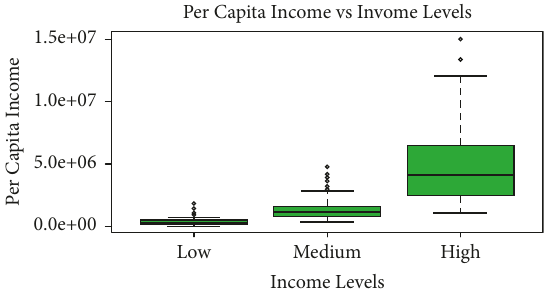
Figure 5: Box-plot of per capita income ( y -axis in TZS) in low, medium, and high-income samples ( x